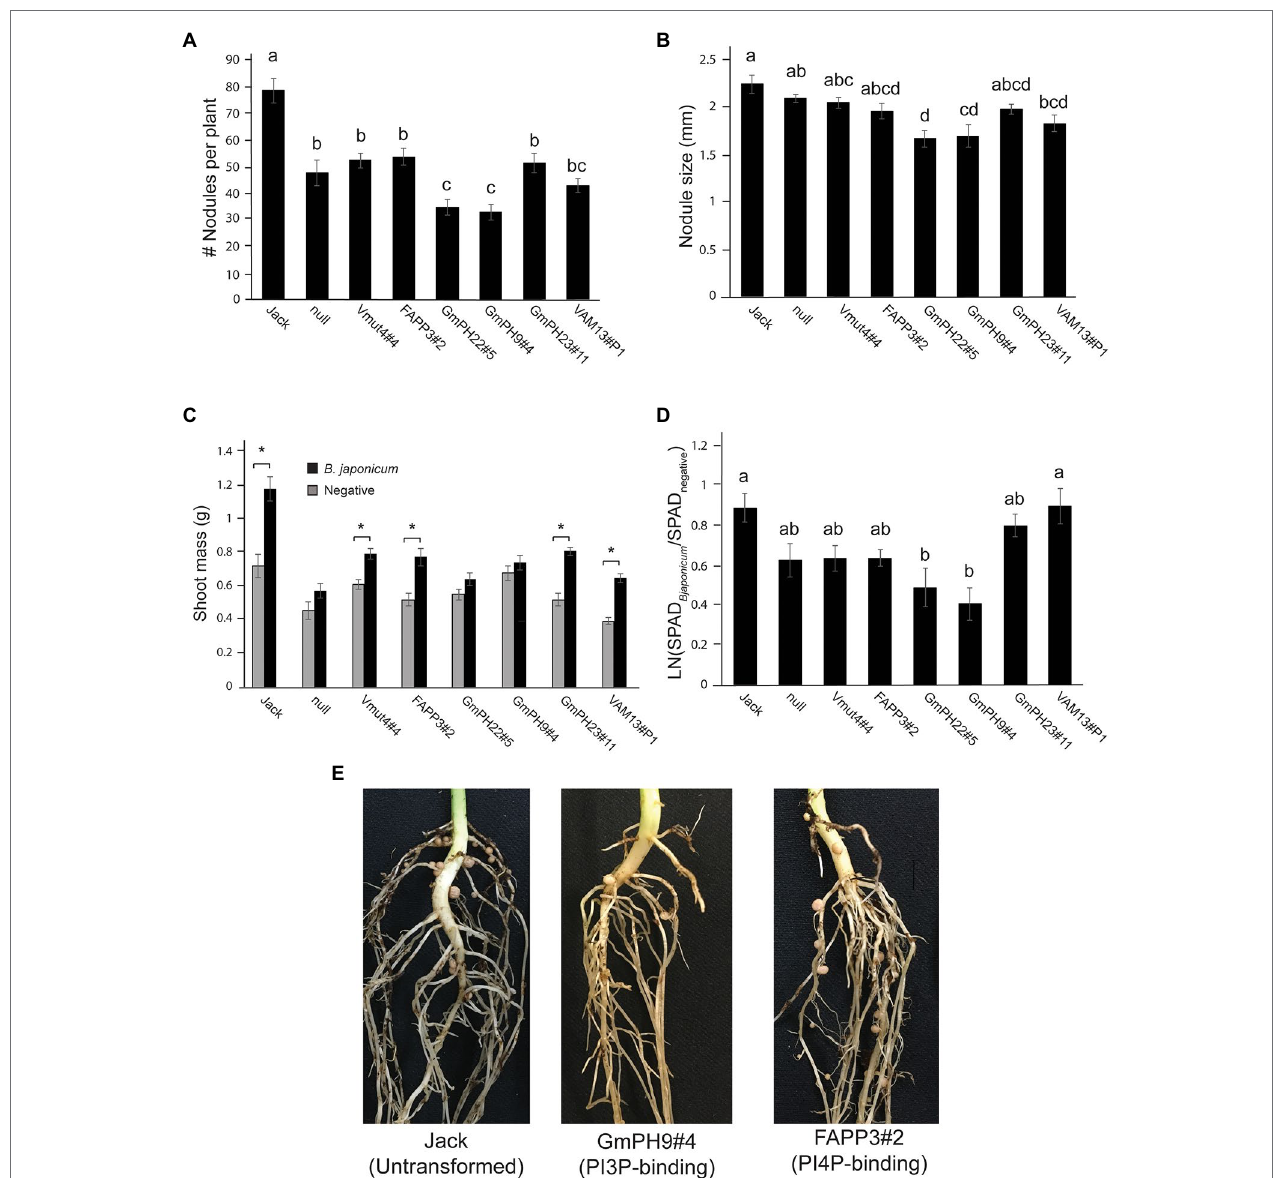
FIGURE 3 | Effect of mutualistic nitrogen-fixing Bradyrhizobium japonicum USDA 110 on transgenic soybean lines. (A) Nodule count per plant. (B) Average size of the three largest nodules per plant. Data from A and B were analyzed using a one-way ANOVA with significance groups assigned by a Tukey HSD post hoc test, with significance threshold at p < 0.05. Each bar represents the average of 13 plants from a randomized block design. Error bars indicate the SD of the mean. (C) The average shoot mass for plants inoculated with sterile buffer (gray bars) or 10 6 cells B. japonicum (black bars). Asterisks show the soybean lines where the shoot masses of the sterile-inoculated plants are significantly different than the B. japonicum -inoculated plants at a threshold of p < 0.05. (D) Response ratio of chlorophyll content of B. japonicum -inoculated plants relative to mock-inoculated plants. Measurements represent the log of the Soil Plant Analysis Development (SPAD) chlorophyll scores of inoculated plants over SPAD scores of mock-inoculated plants. Letters indicate significance groups as determined by a mixed model regression analysis followed by a Tukey HSD post hoc test. (E) Photographs show representative plants, 3 weeks